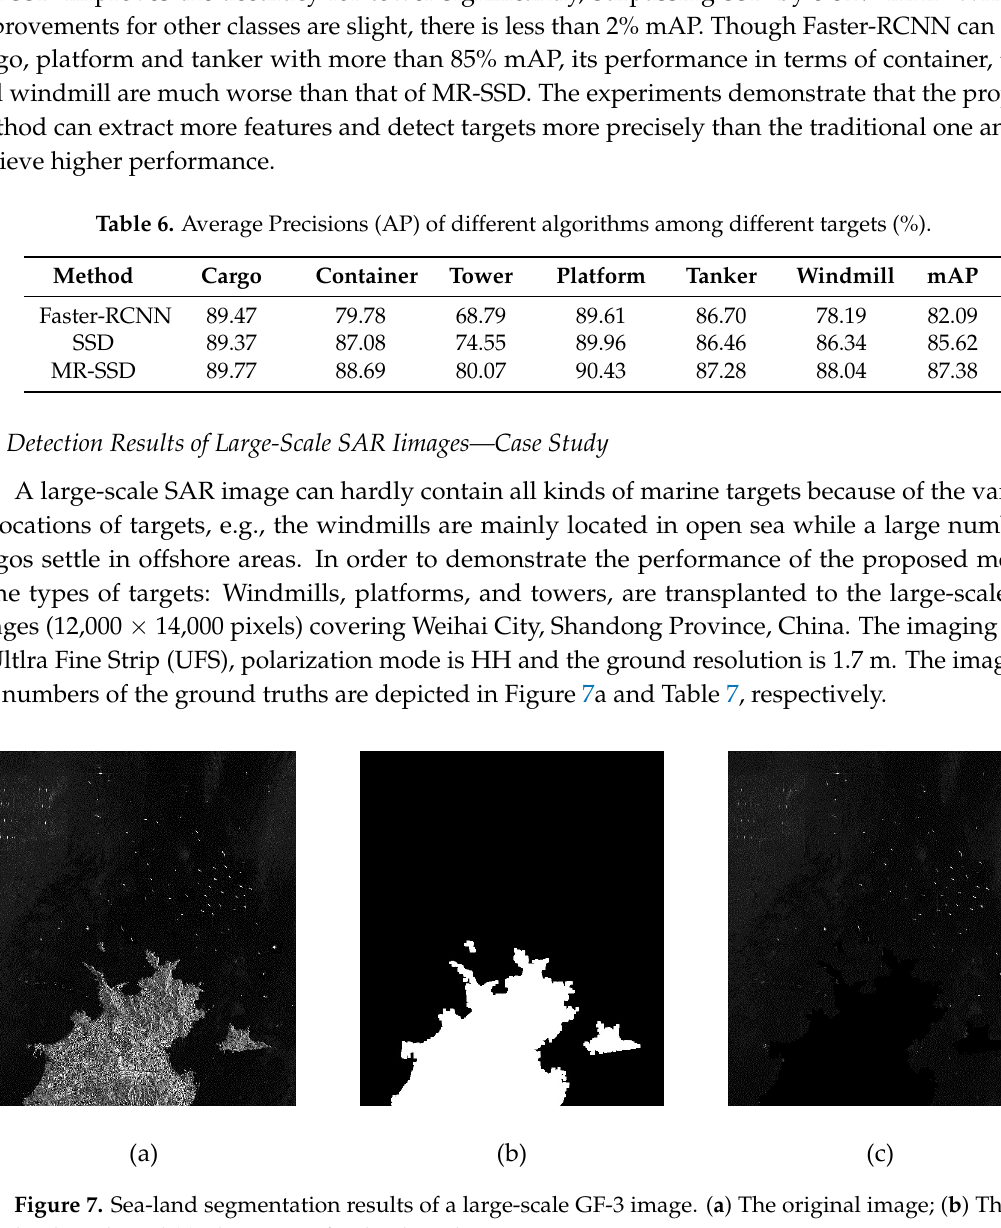
Table 6. Average Precisions (AP) of different algorithms among different targets (%).